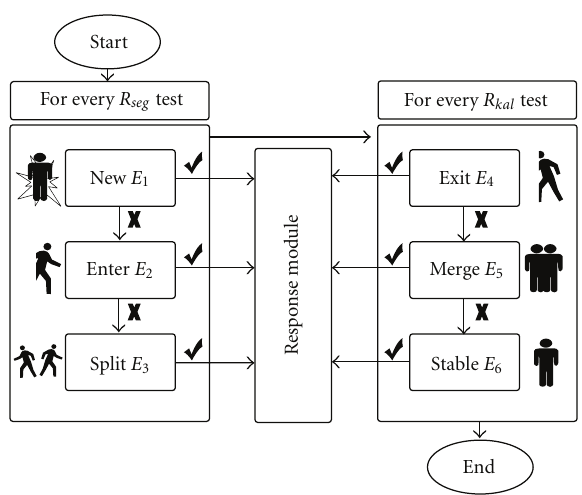
Figure 15: The flow chart of tracking events algorithm.